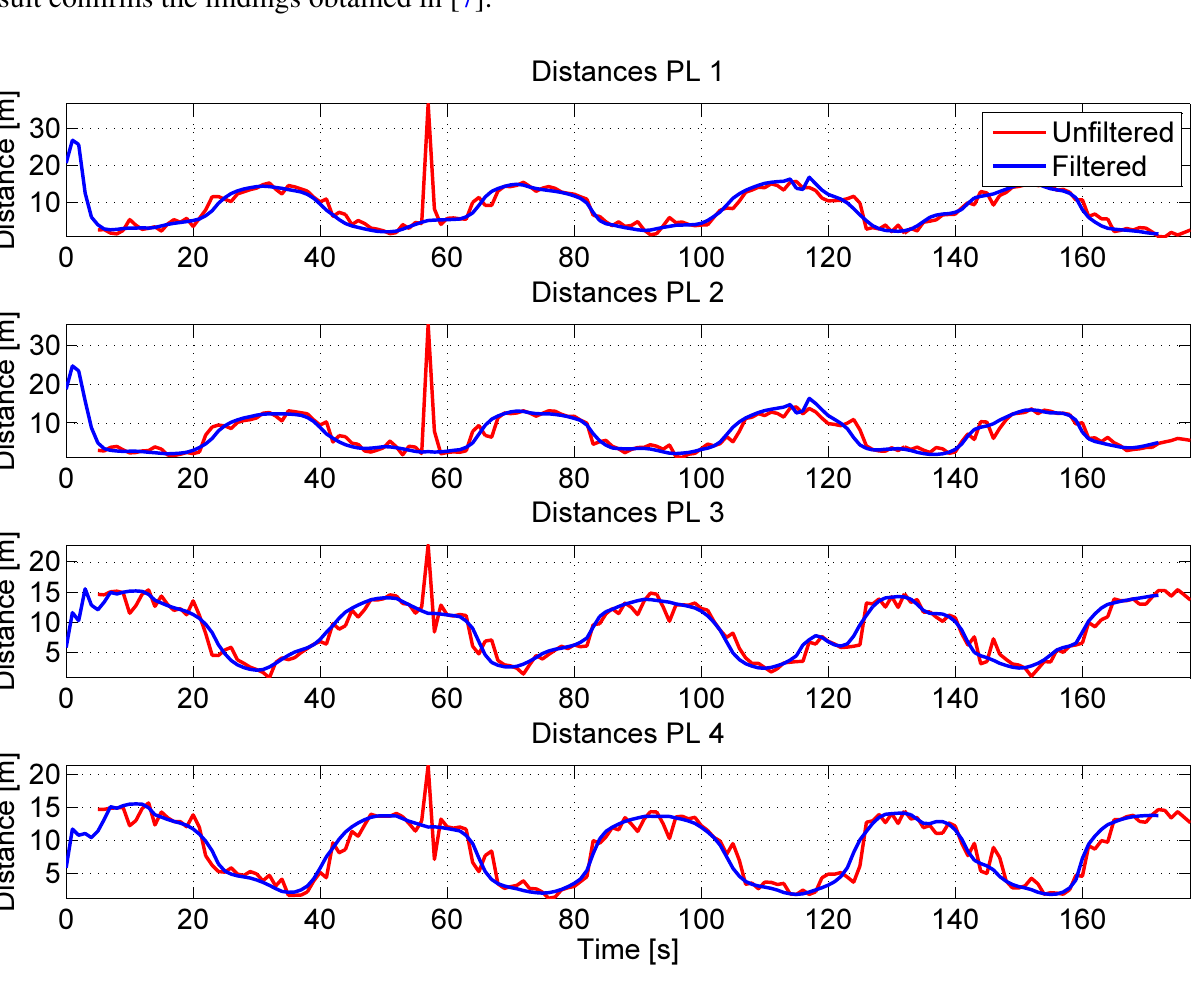
measurements of the four outdoor 0